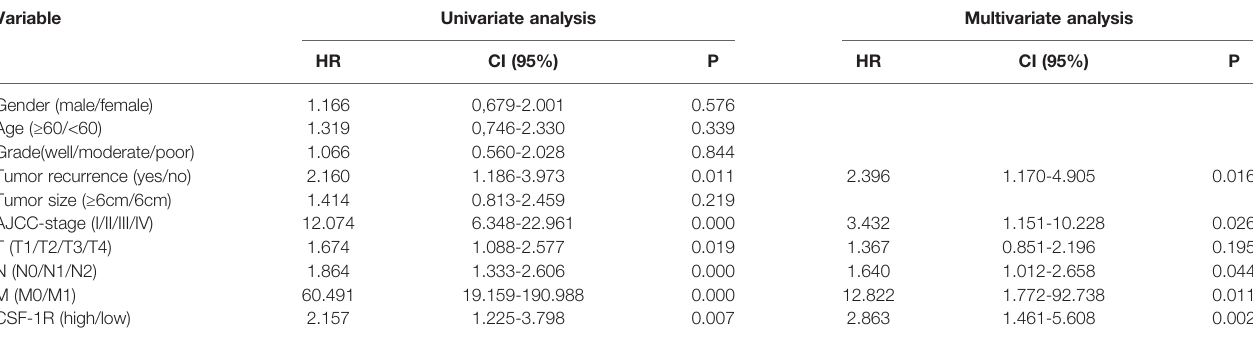
TABLE 2 | Univariate and multivariate Cox regression analysis of clinicopathologic variables in 103 COAD patients. Variable Univariate analysis Multivariate analysis HR CI (95%) P HR CI (95%) P Gender